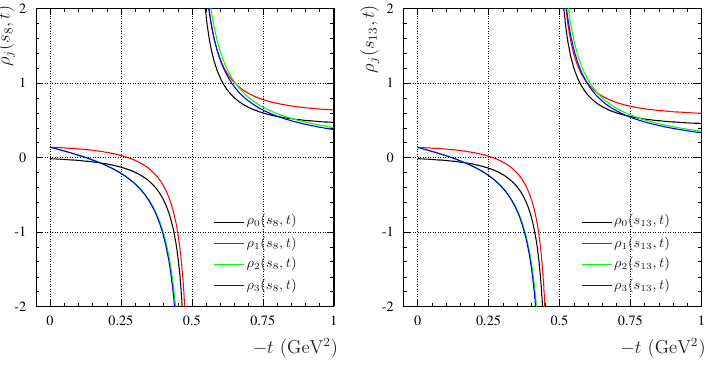
Figure 2. The ρ ( s , t ) values at 8 (left), 13 TeV (right) from the rotated mBP2 model described in the